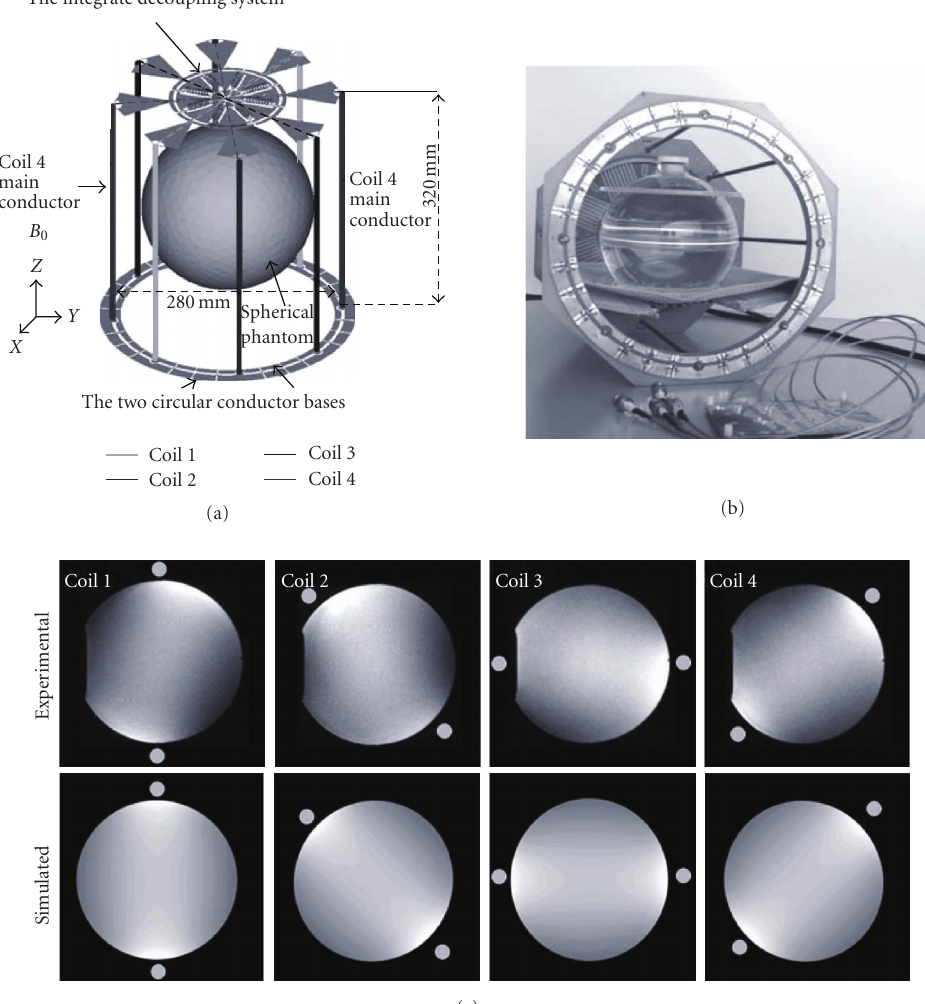
Figure 2: (a) FDTD model setup of the RPA head coil and spherical phantom, (b) prototype RPA coil and (c) Signal intensities corresponding to each coil element evaluated with the FDTD method and obtained experimentally during MR